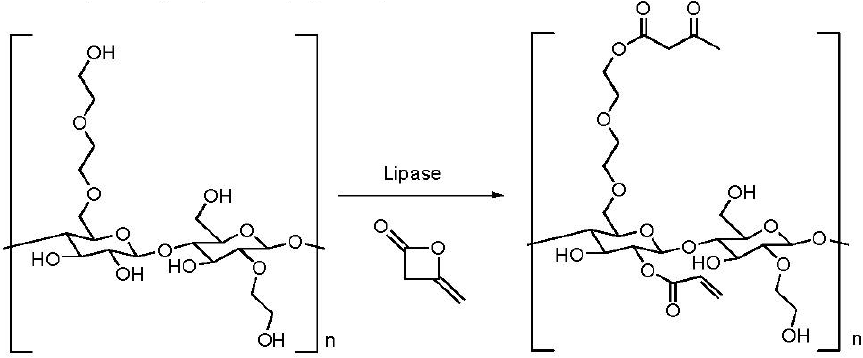
Figure 9. Lipase-catalyzed reaction of diketene with HEC to form an acetoacetonate substituent.